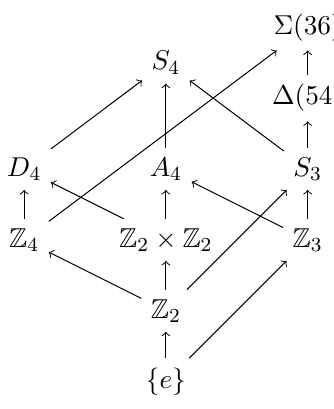
Figure 1 . Tree of finite realizable groups of Higgs-family transformations in